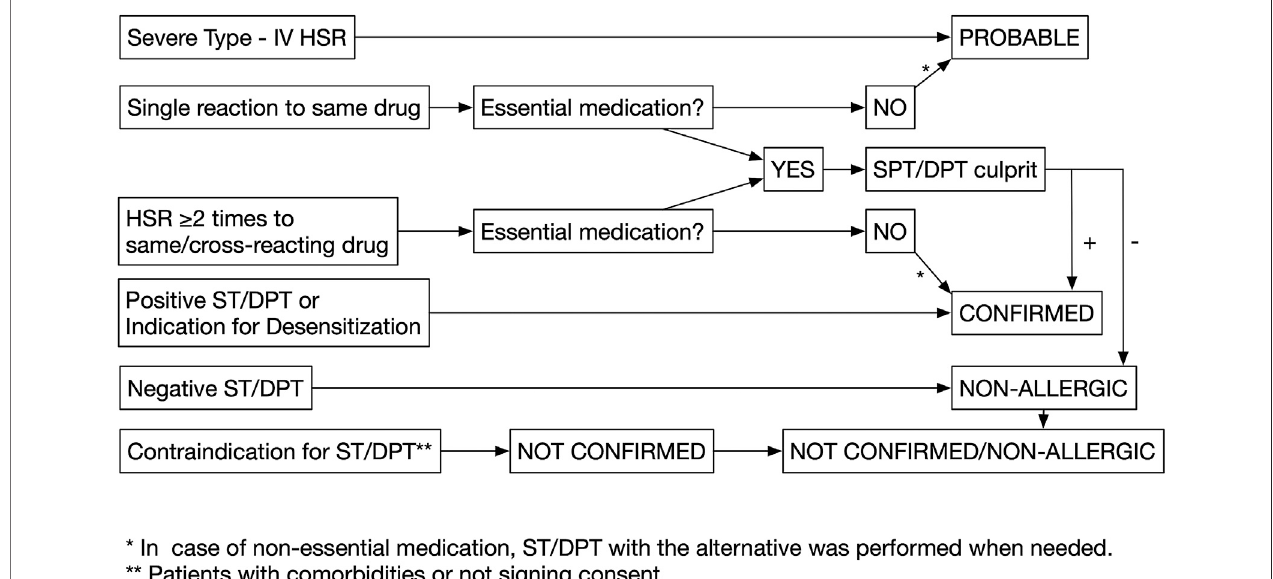
FIGURE 1 | Diagnostic methods fl